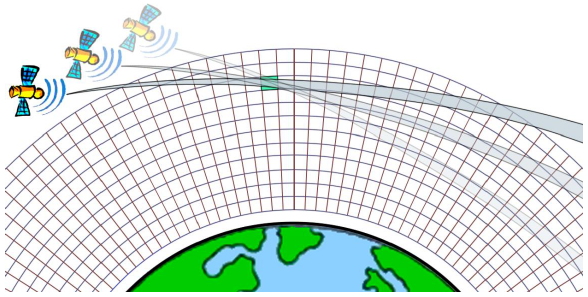
Figure A1. Picture illustrating the 2-D discretisation of the atmo- sphere and the merging of information from different observation geometries in the geo-fit